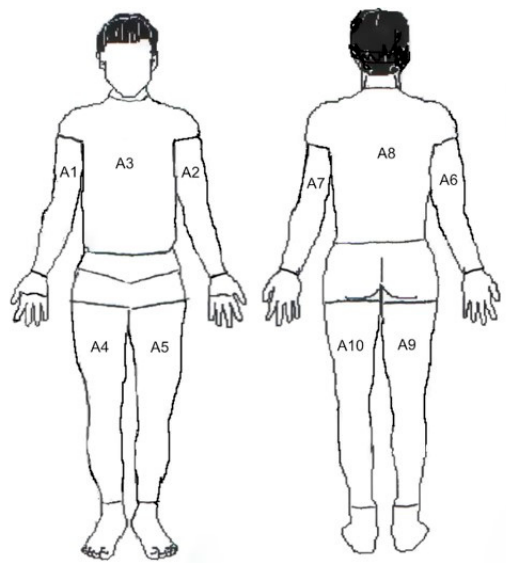
Figure 1. Method of determining the individual fields for thermographic analysis.